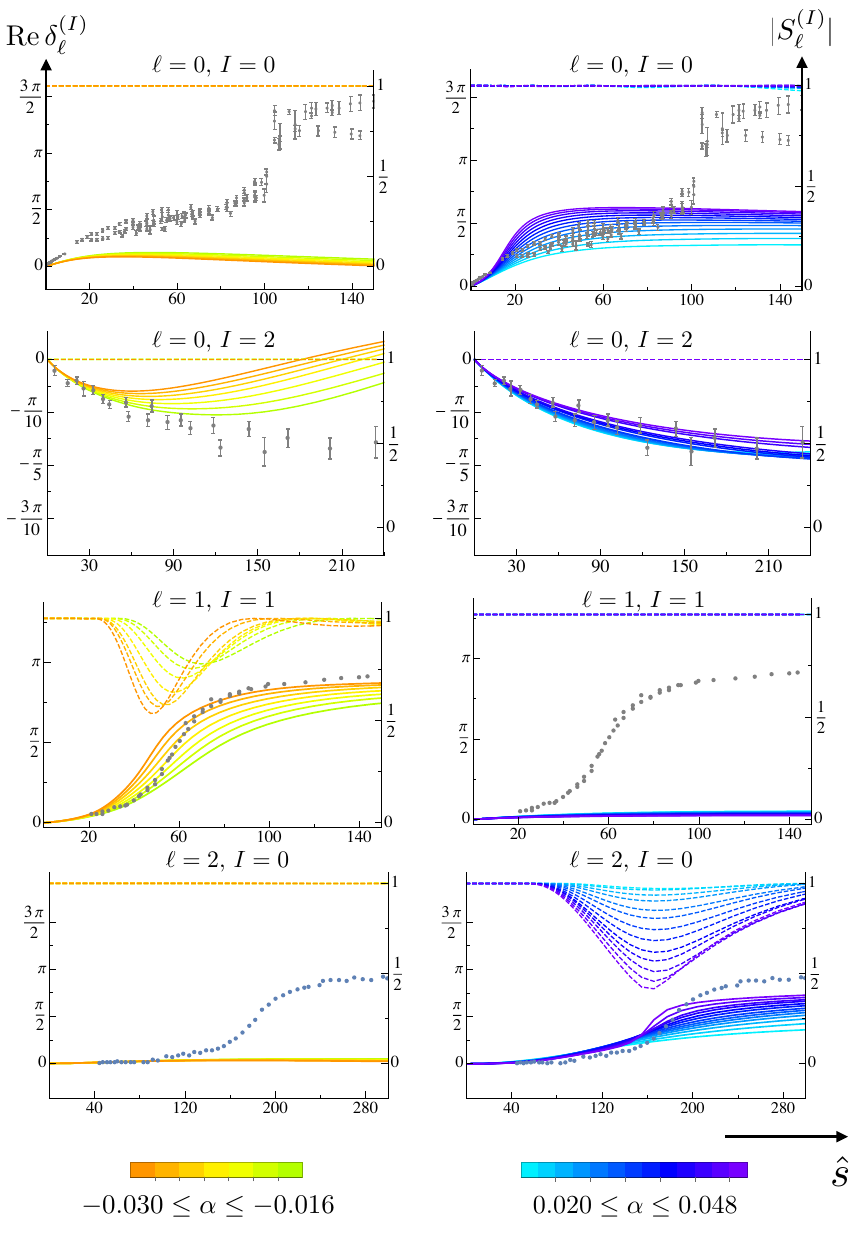
Figure 4 . Real part of the phase shifts δ ( I ) values of the corresponding amplitudes | S ( I ) and isospins along the boundary as function of ˆ s = s/f 2 and error bars are experimental phase shifts for real world massive pions [30–36]. 7 The comparison is done by plotting the experimental data also as a function of the square of the center of mass momentum in units of f π , i.e. ( s − 4 m 2